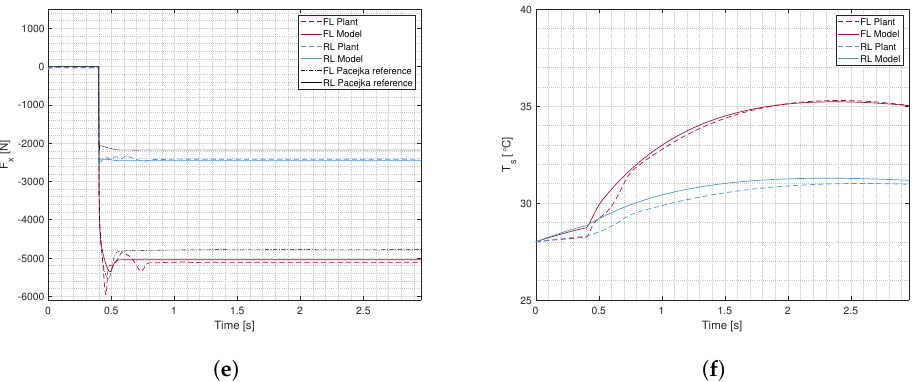
Figure 12. full-car model ’myVeh’ validation. ( a ) Brake torque input; ( b ) Longitudinal slip; ( c ) Vehicle longitudinal velocity; ( d ) Tyre normal load; ( e ) Tyre longitudinal force; ( f ) Tread surface